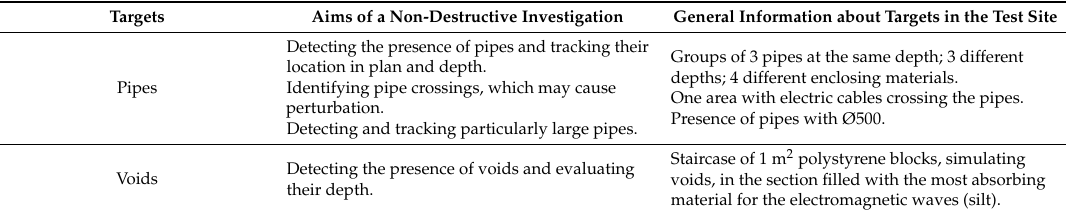
Table 2. Target types, possible objectives of a non-destructive investigation, general properties of the targets embedded in the